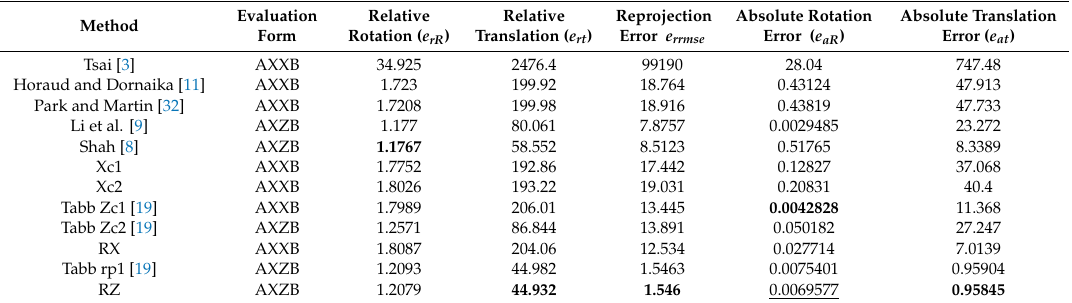
Table 5. Comparison of methods using the described error metrics for dataset 6 with robot pose and visual